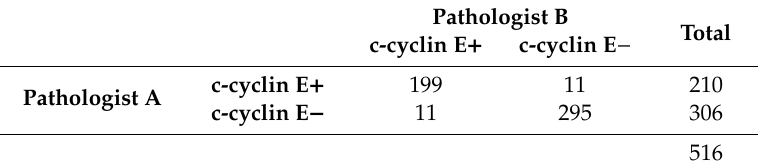
Table 2. Concordance between two independent pathologists for the Nottingham cohort ( n = 516).